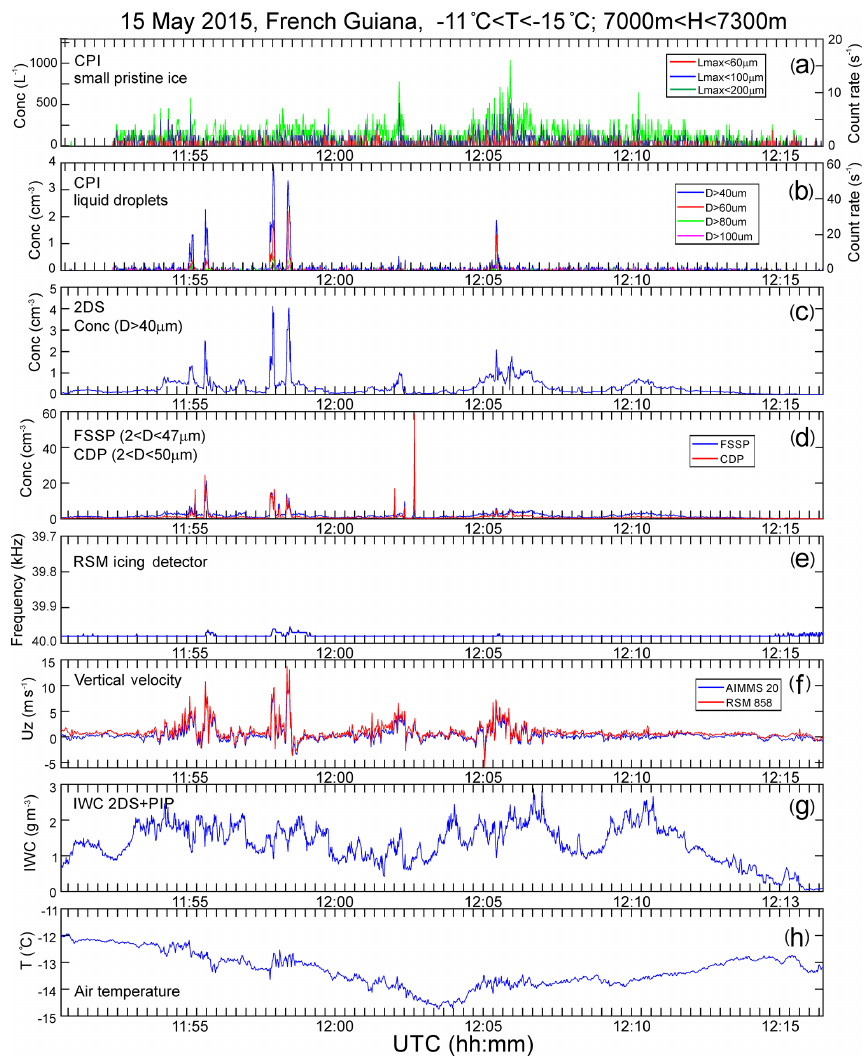
Figure 8. Same as in Fig. 5. The altitude of measurements varied between 7000 and